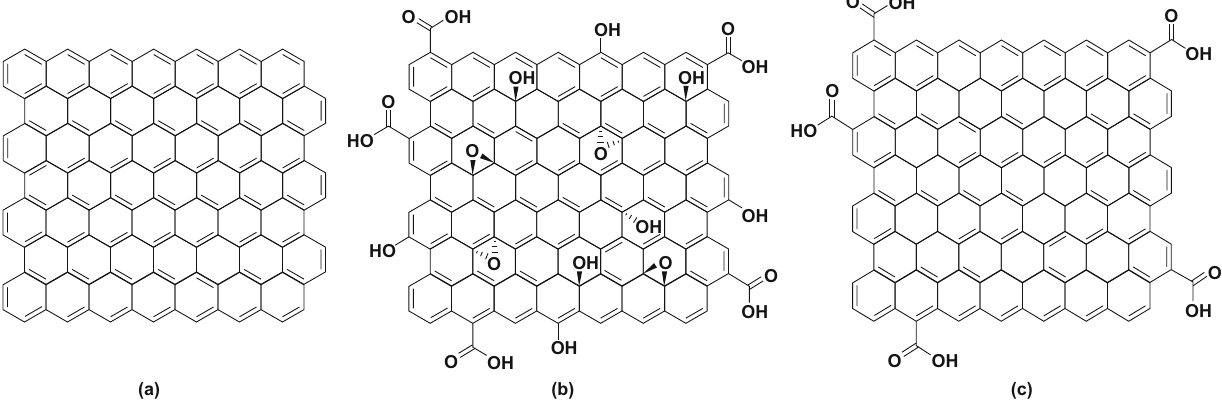
Fig. 3 Schematic representation of structures of graphene, GO and RGO [24]. Copyright (cid:2) Elsevier